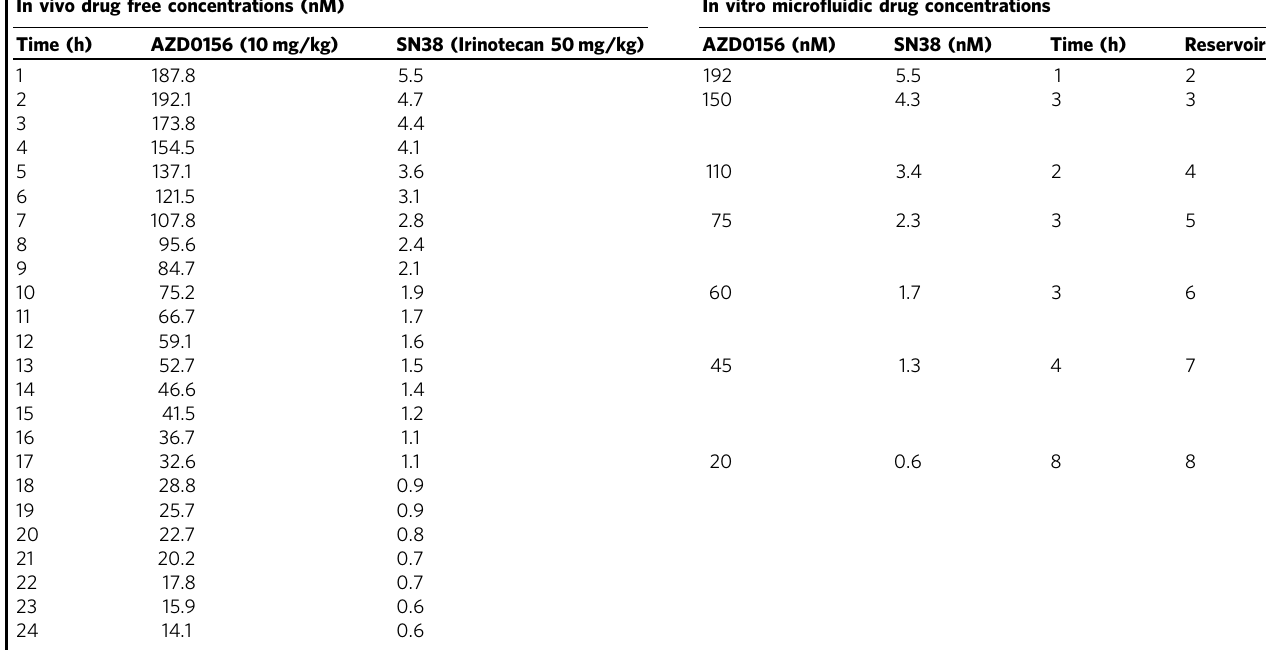
Table 1 In vivo free drug plasma concentrations (determined by LC-mass spectrometry and population-based PK model) and mimicked concentrations in the micro fl uidic